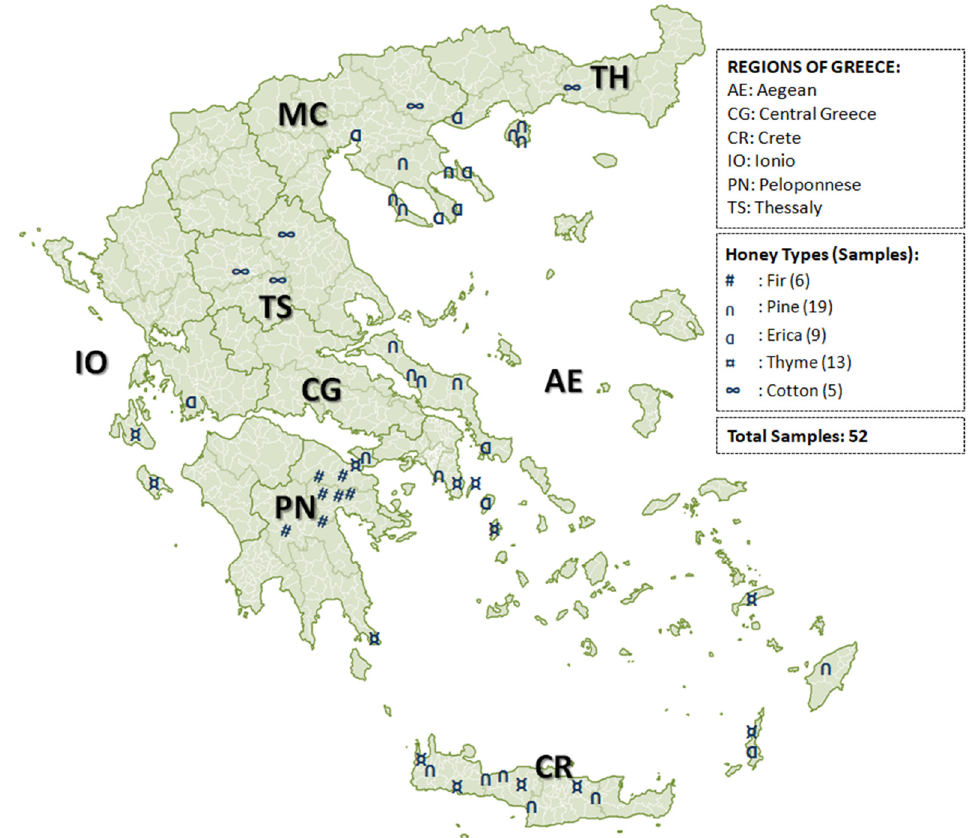
Figure 1. Regions of collected honey samples.